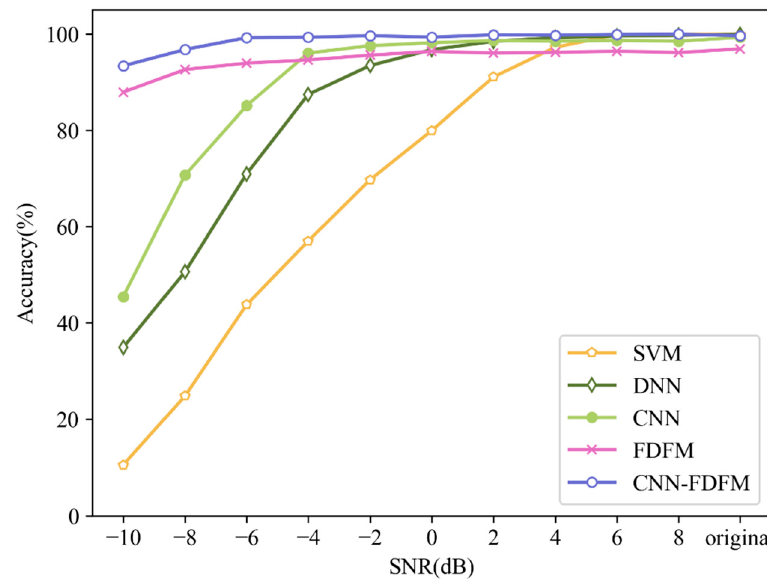
Figure 17. Diagnosis results of different models under different SNRs.